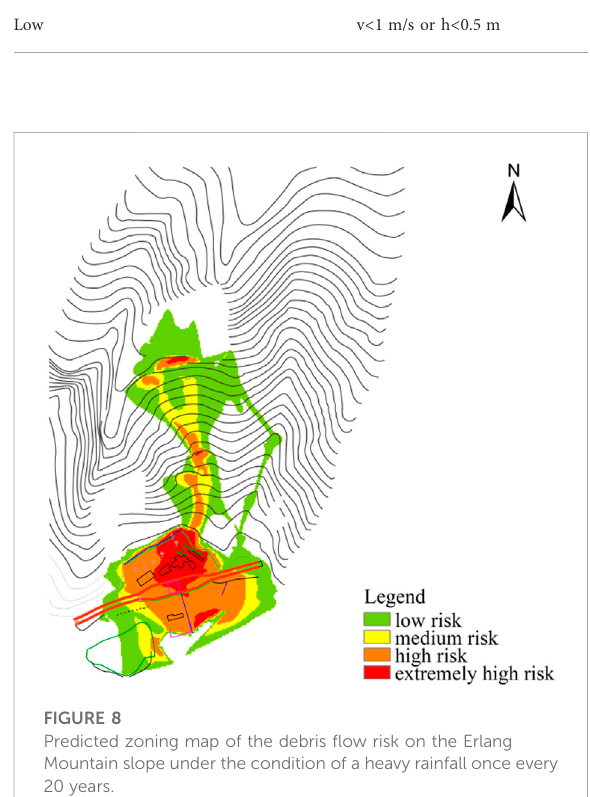
FIGURE 8 Predicted zoning map of the debris fl ow risk on the Erlang Mountain slope under the condition of a heavy rainfall once every 20